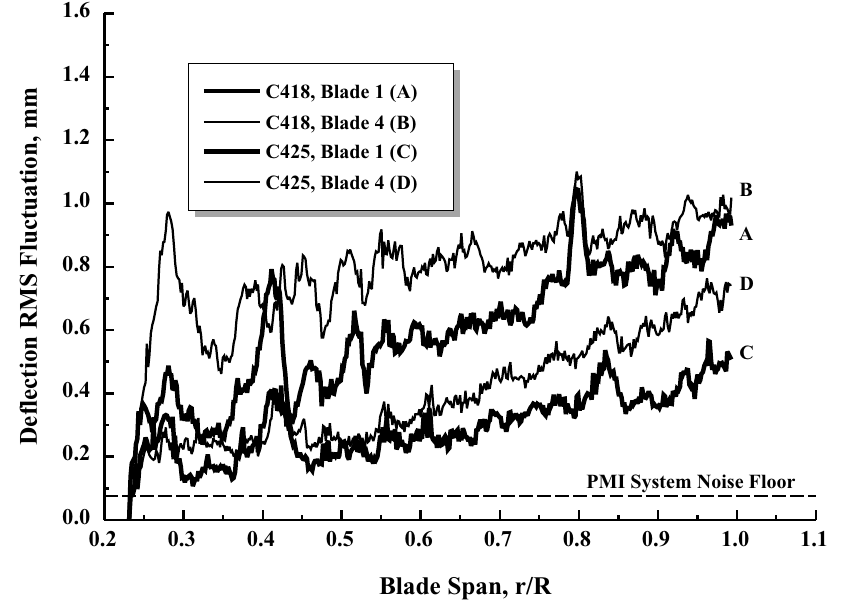
Fig. 15. Blade-to-blade comparison, dynamic blade deflection at 25% chord, Ψ = 90 ◦ .